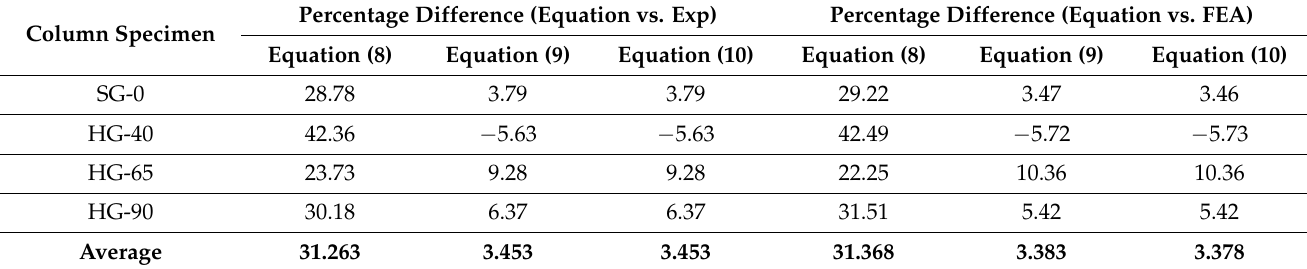
Table 5. Comparison of ultimate axial load-carrying capacity in